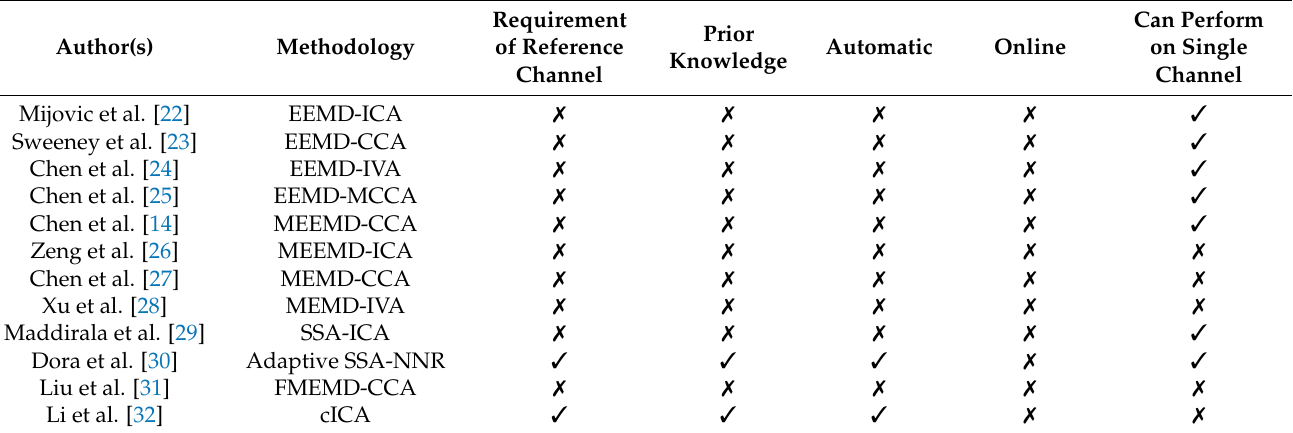
Table 1. Comparison of recently developed hybrid techniques for the removal of EMG artifacts from the EEG